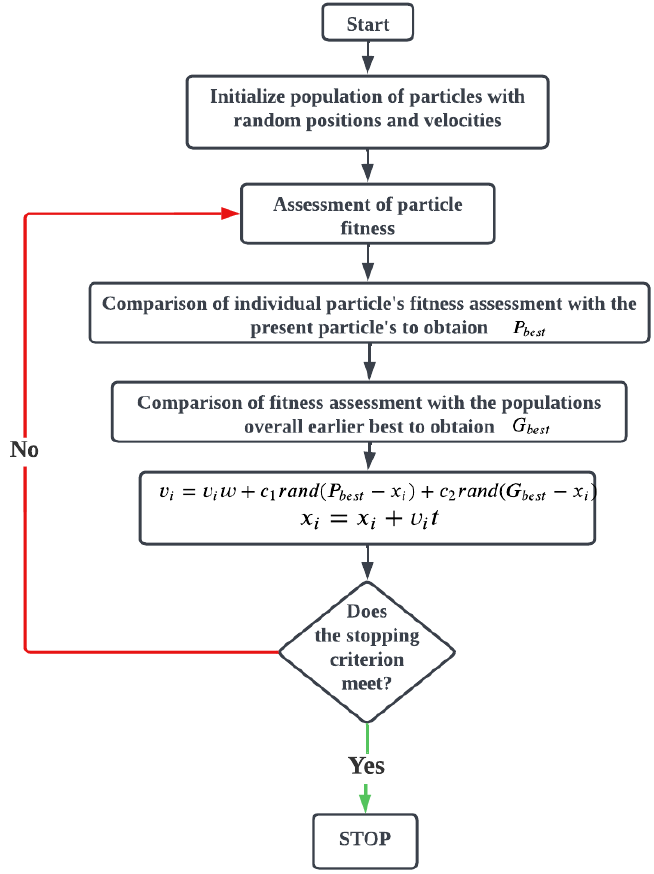
Figure 3. Flow chart for Particle Swarm Optimization